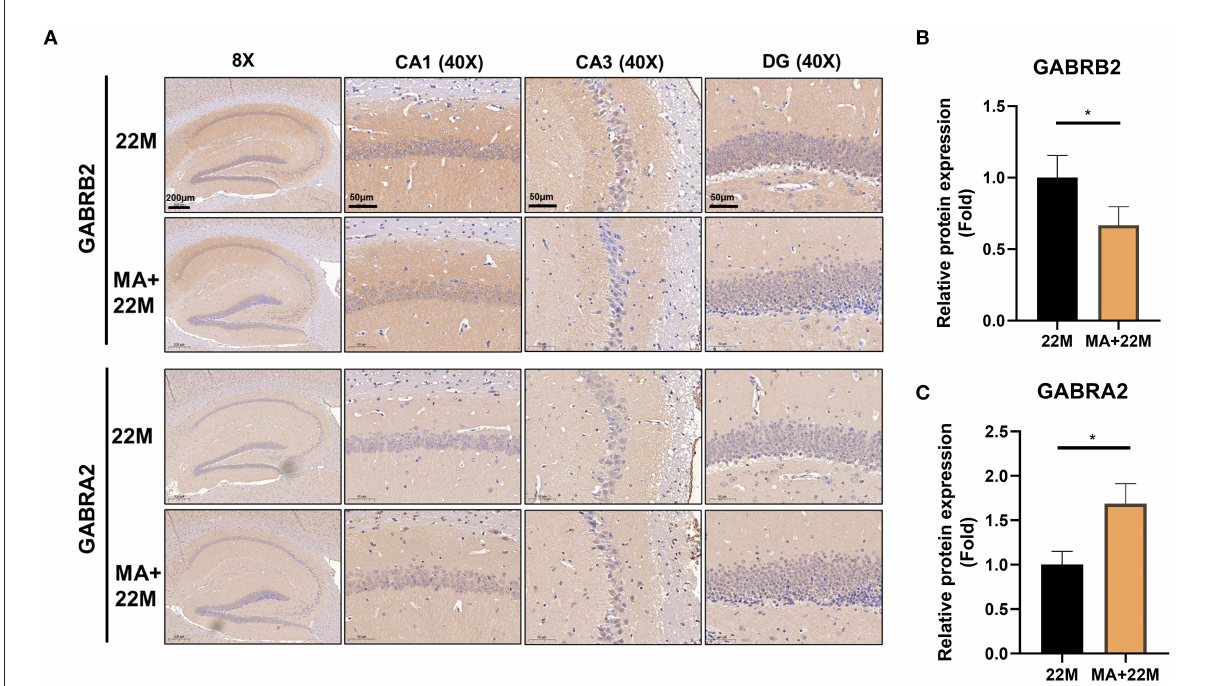
FIGURE7 Validation of GABRB2 and GABRA2 expression by IHC of hippocampus in MA-treated aging mice. (A) IHC of GABRB2 and GABRA2 in the hippocampus between 22M and MA + 22M group. Magnifications and scale bars were shown in (A) . (B,C) Relative expressions of GABRB2 and GABRA2 were calculated by IHC. Data were represented as mean ± SD and were analyzed by Student t -test. * P <